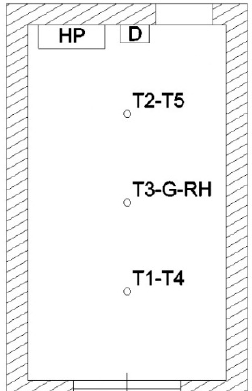
Figure 3. Plan of an outdoor test cell: HP (Heat Pump); D (Datalogger); T (Temperature sensors): T1 and T2 at 1.8 m in height, T4 and T5 at 0.5 m; G (Globe ‐ thermometer); RH (Relative Humidity).